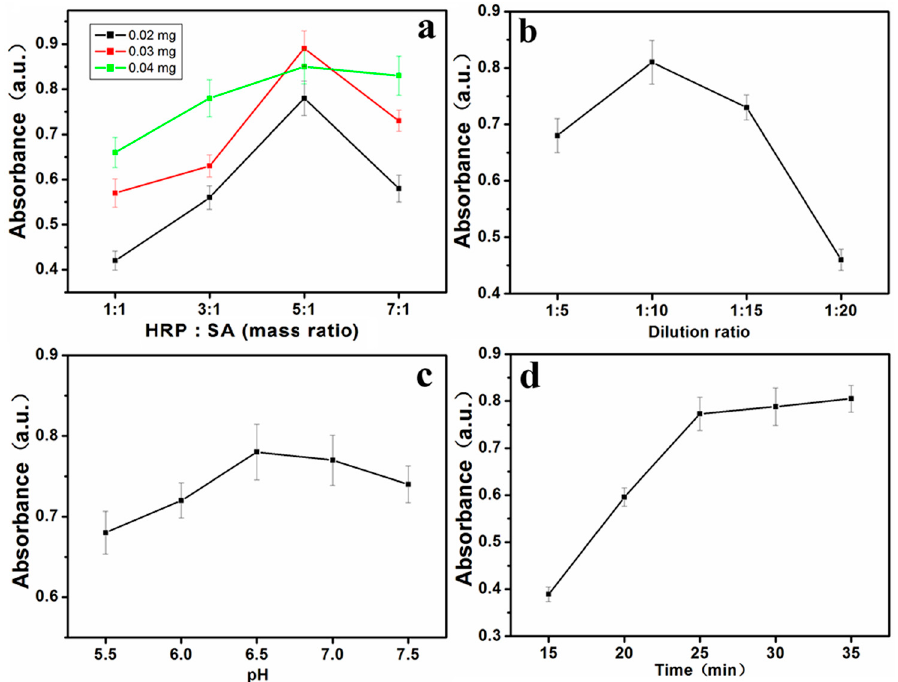
Figure 2. Detection of Cry1Ab with different amounts of HRP and SA. ( a ), at different dilution ratio ( b ), pH values ( c ) and incubation times ( d ) for HRP&SA/ZIF-8 nanocomposites’ binding.